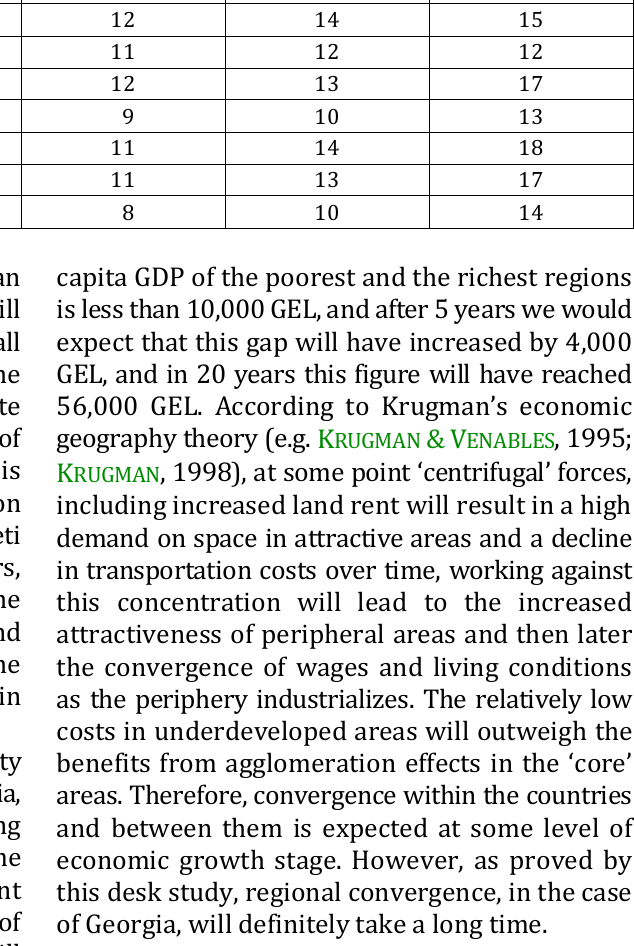
Table 2. GDP per capita in the regions of Georgia in 2017 and the minimum growth rate needed in the Shida Kartli region in order to converge with the economic output other regions within 5, 10 or 20 years (Source: own elaboration based on data from the National Statistics Office of Georgia) Minimum growth Minimum growth Minimum growth rate in the rate in the rate in the GDP per capita Regions poorest region for poorest region for poorest region for (thousand GEL) convergence convergence convergence (within 20 years) (within 10 years) (within 5